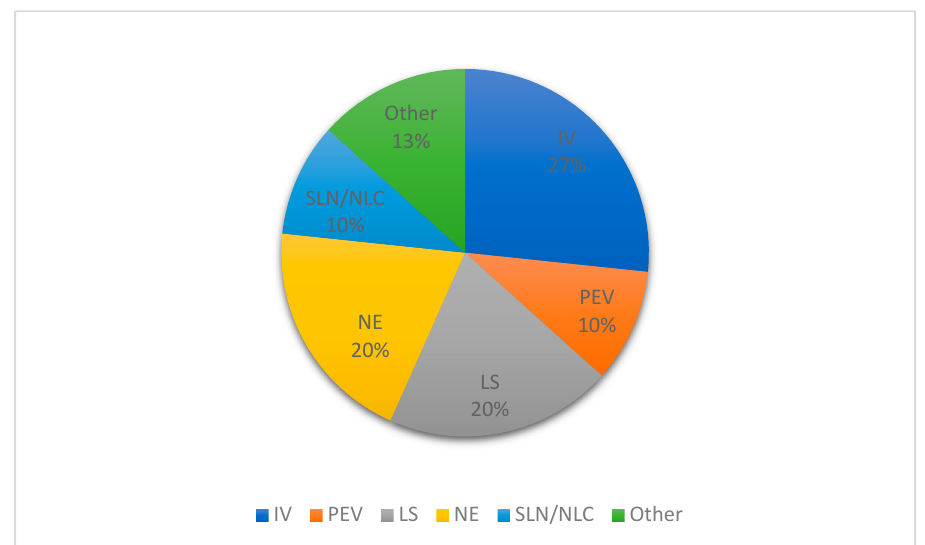
Figure 6. Nanostructured systems used in formulations containing essential oils and/or isolated terpenes excipients for topical administration. IV: invasomes, PEV: permeation-enhancing vehicles.